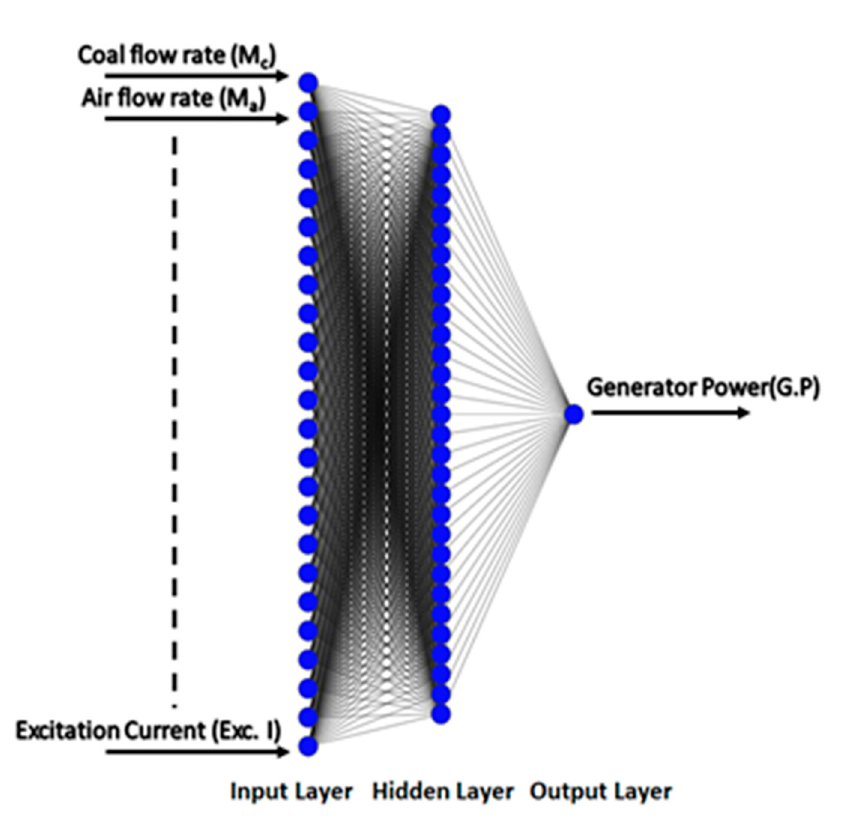
Figure 5. Structure of the optimal ANN.